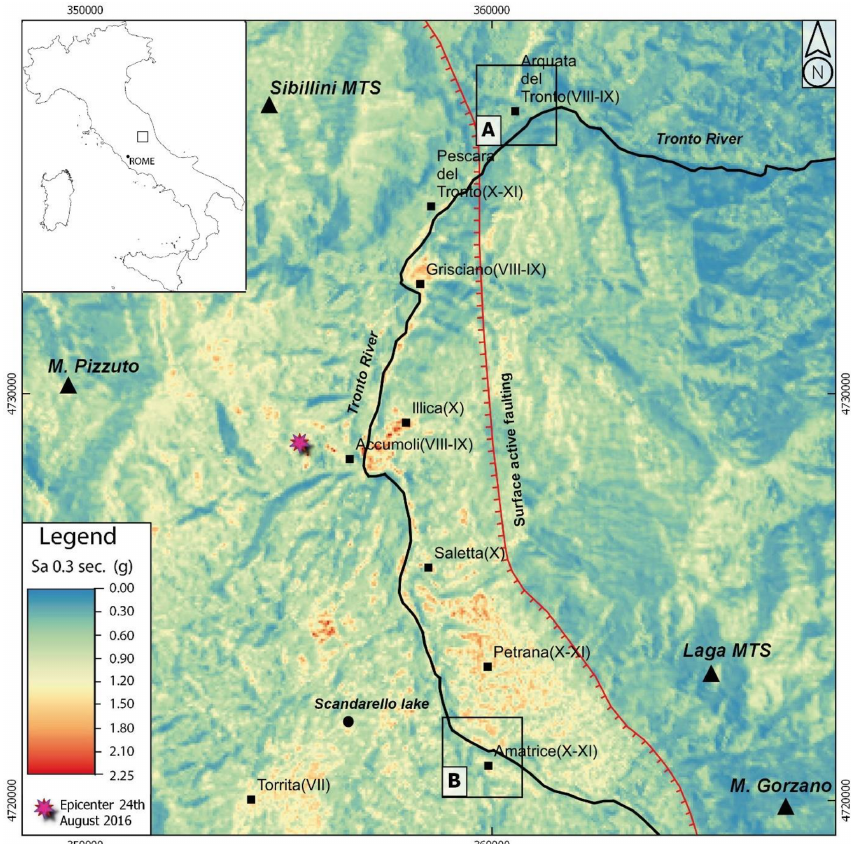
Figure 6. Ground motion prediction map of Sa 0 . 3 (resolution of 50m × 50m) regarding the central Italy earthquake that occurred on 24 Au- gust 2016. I_MCS values retrieved by Galli et al. (2017) are reported next to the name of the villages. Squares A and B refer to the close-ups at Arquata del Tronto and Amatrice, respectively. The surface active faulting, sketched in the figure, has been slightly modified after Galli et al.